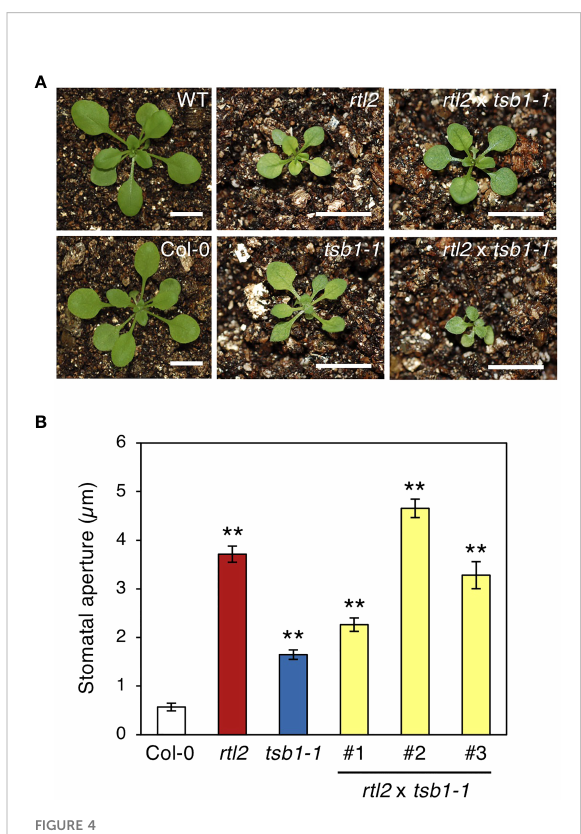
FIGURE 4 Phenotypes of test-crossed plants. (A) Five-week-old WT, Col-0, rtl2 x tsb1-1 ). Plants were rtl2 , tsb1-1 and test-crossed F 1 plants ( grown on MS plate for 4 weeks and transferred to soil for 1 week. The scale bar represents 1 cm. (B) Stomatal aperture of 5- week-old Col-0, rtl2 , tsb1-1 and test-crossed F 1 plants ( rtl2 x tsb1-1 ) under illuminated growth condition. Rosette leaves were detached from the plants at ZT4-7 and immediately subjected to measurement of stomatal aperture. Values are means of > 25 stomata with SDs. Asterisks indicate a signi fi cant statistical difference relative to Col-0 by Student t test (** P <